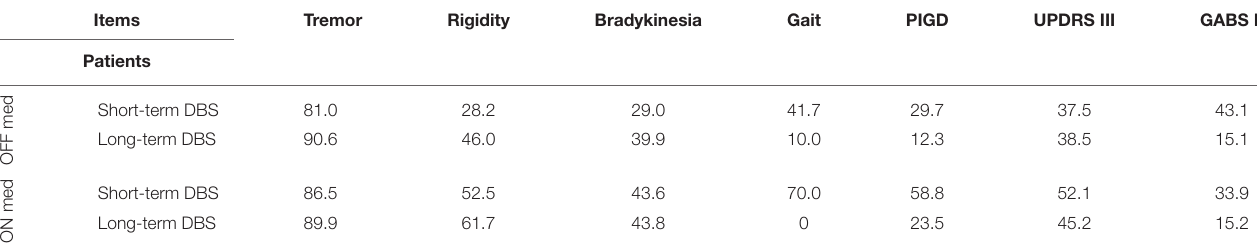
TABLE 3 | Percentage change (decrease) of UPDRS III and GABS II scores after turning stimulation ON in PD patients with short- and long-term stimulation. Items Tremor Rigidity Bradykinesia Gait PIGD UPDRS III GABS II Patients